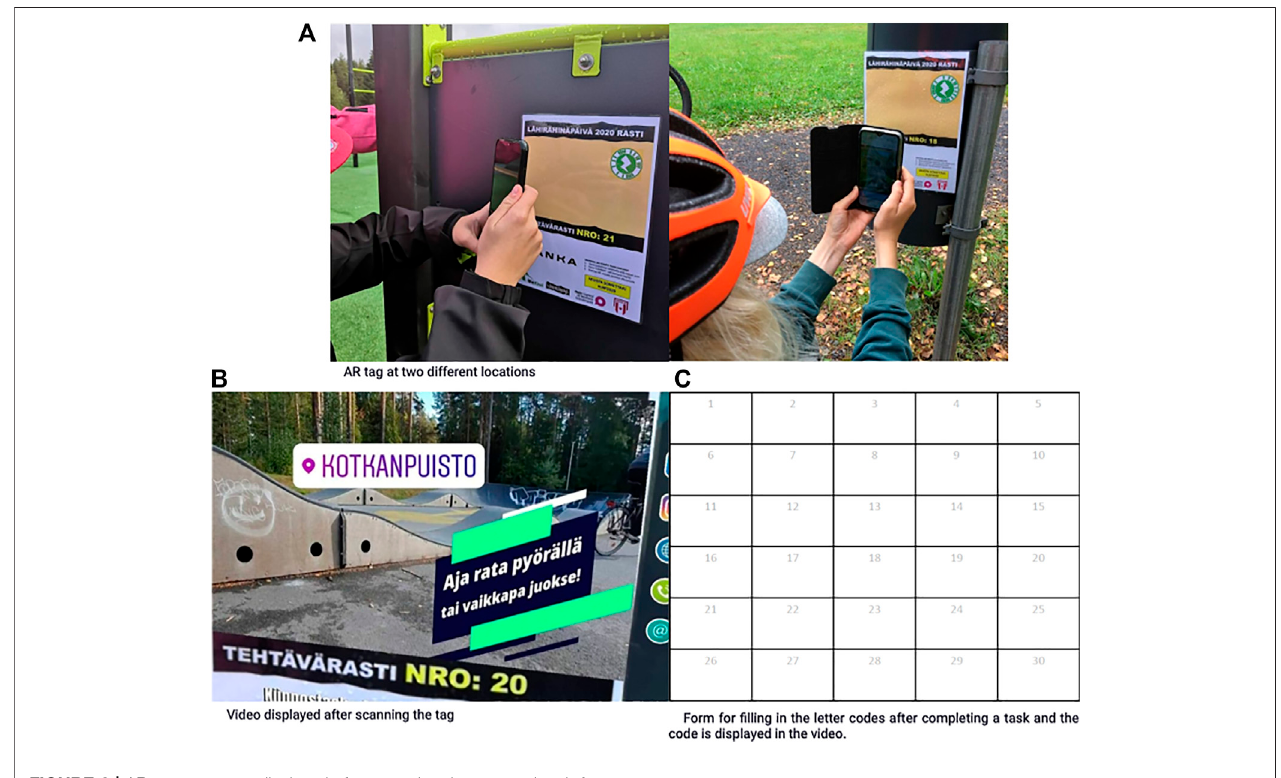
FIGURE 3 | AR tags, content displayed after scanning the tag, and task form.